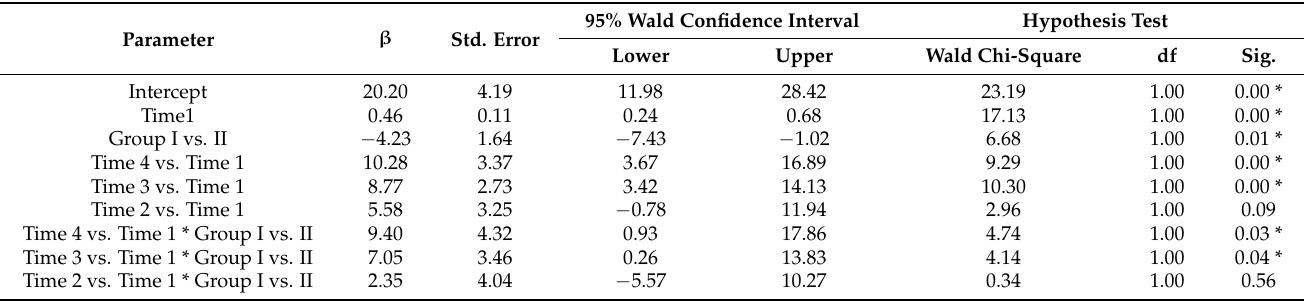
Table 3. Patterns of relationship among times and groups in test